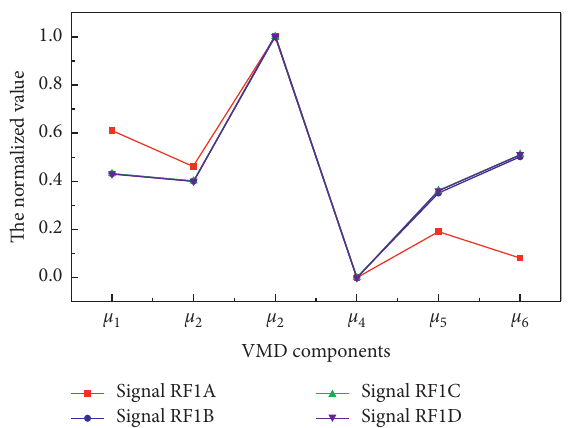
Figure 7: Normalized singular spectrum entropy of the four signals.